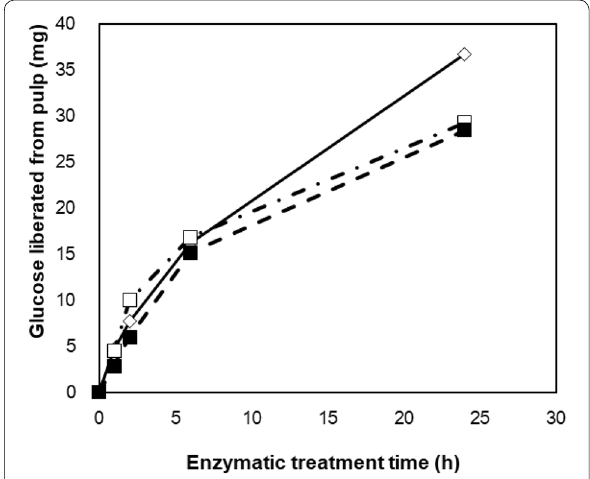
Fig. 2 The amount of glucose liberated from acacia pulp by the enzymatic treatment with the enzyme dose 12.7 FPU/g. Open diamond: filter paper, open square: kraft pulp with the kappa number 22.8, and solid square: SP with the kappa number 23.0. Enzymatic treatment: pulp 50 mg, acetate buffer pH 4.5 and 1.5 mL and temperature at 45